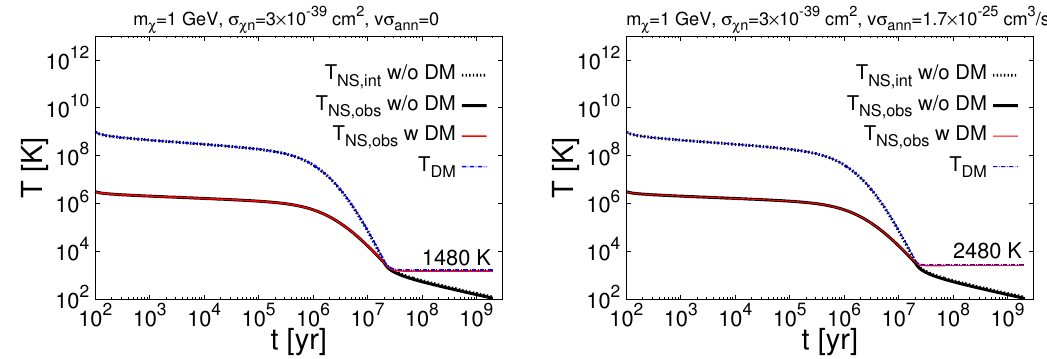
Figure 2 . The time evolution of NS temperatures including DM heating. The left panel does not have a contribution from DM annihilation, and the right panel